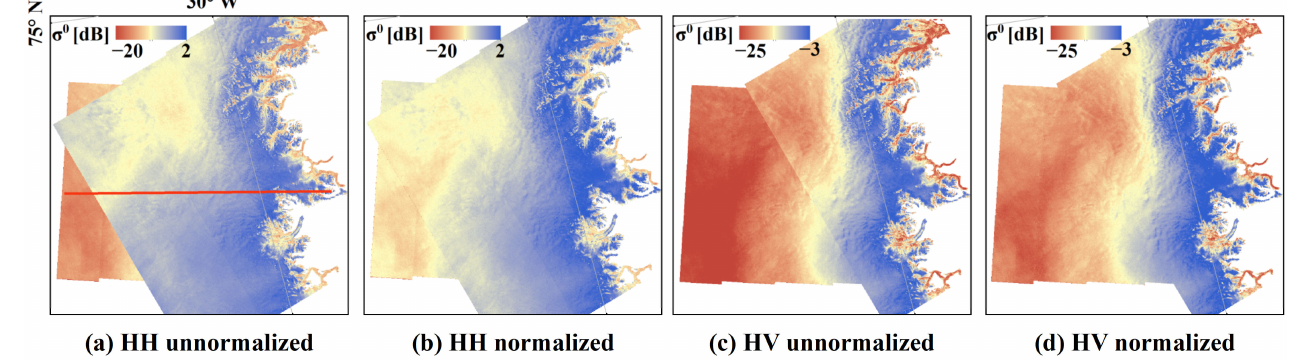
Figure 3. Mosaics of the image pair in EA1 (Eastern Greenland, ascending image on top) before ( a , c ) and after ( b , d ) incidence angle normalization by the incidence angle correction method. EW1 of the HV images was removed. The ascending image was acquired on 19 April 2021 and the descending one was acquired on 16 April 2021.